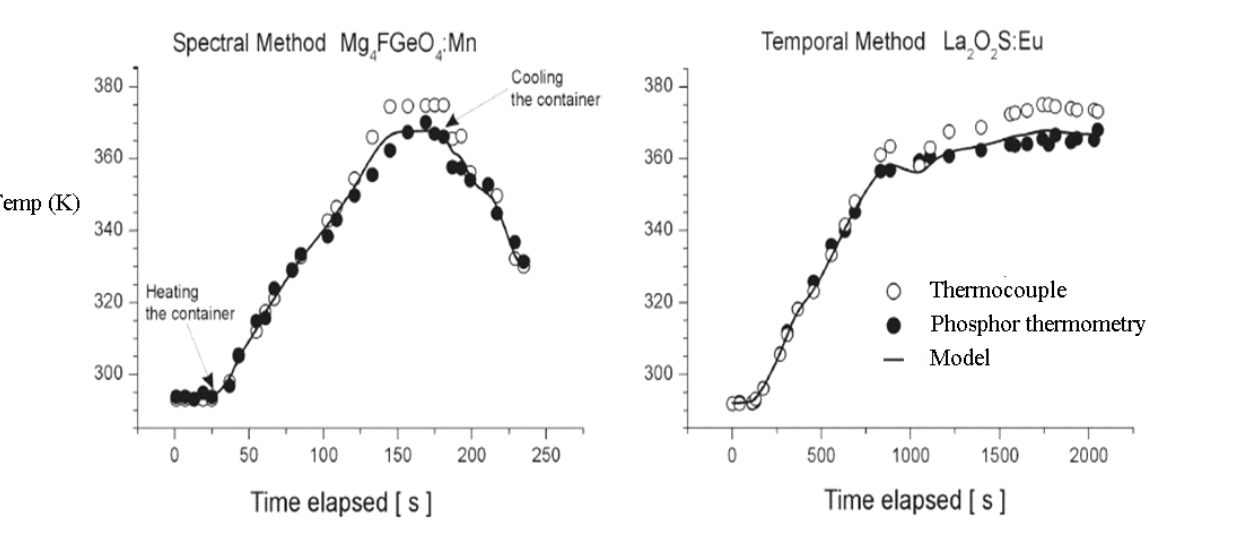
Figure 62. Temperature comparisons from thermocouple values, predicted model values, and actual phosphor measurements